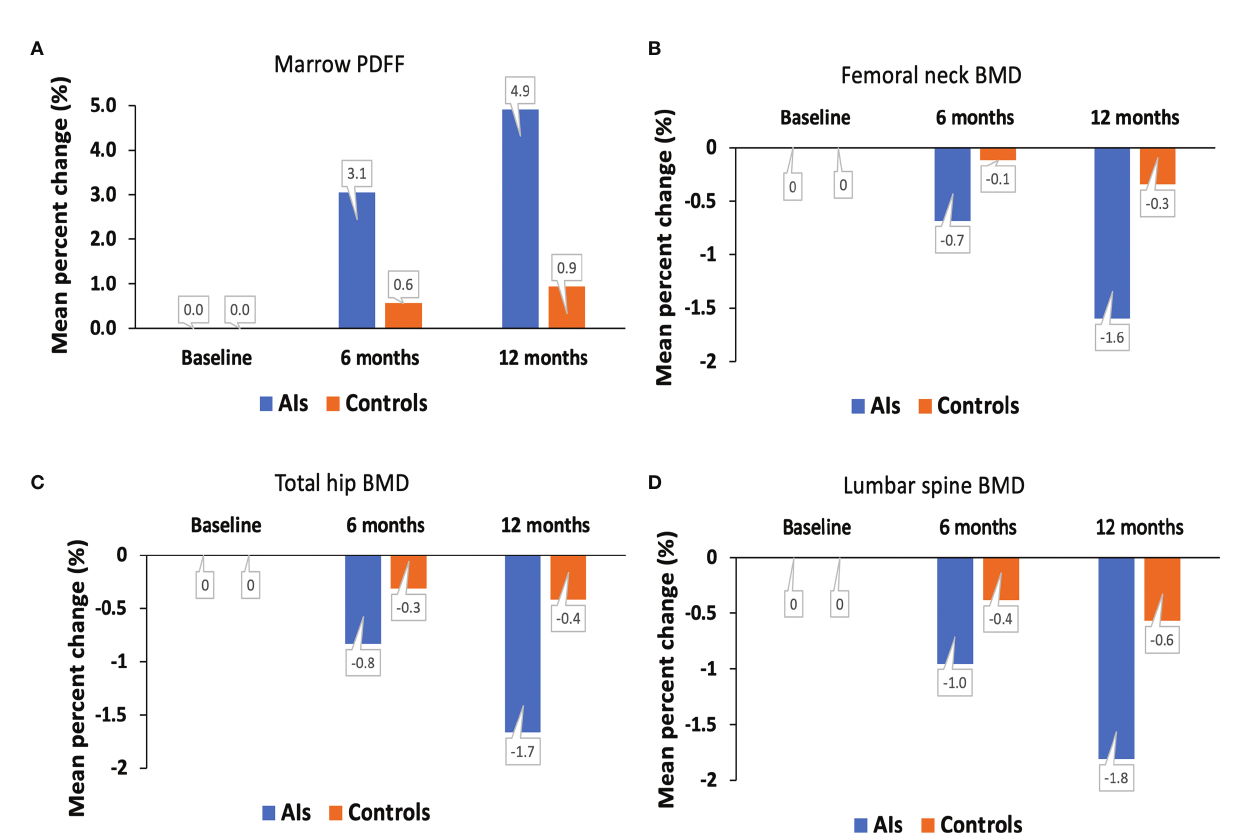
TABLE 2 | Changes in bone turnover biomarkers, BMD and spinal marrow PDFF in AIs-treated group. Parameters